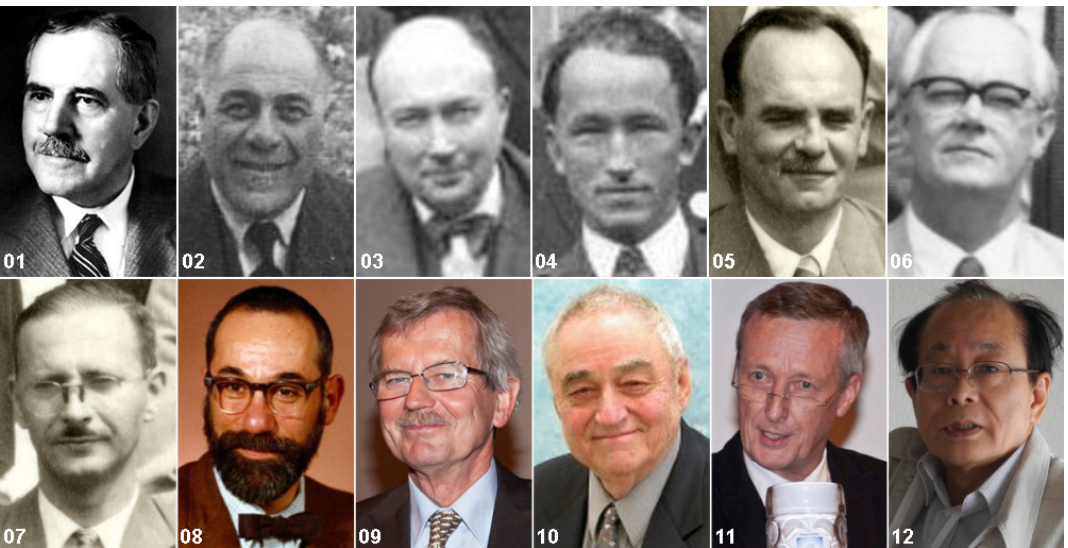
Figure 4. Collection of portraits of the 12 IAMAS secretaries-general serving from 1919 to 2019: (01) Charles Marvin, (02) Filippo Eredia, (03) Philippe Wehrlé, (04) Jacob Bjerknes, (05) Jacques van Mieghem, (06) Reginald Sutcliffe, (07) Warren Godson, (08) Stanley Ruttenberg, (09) Michael Kuhn, (10) Roland List, (11) Hans Volkert and (12) Teruyuki Nakajima. See Table 3 for detailed information. Photo credits: 03 and 04 , cuttings from group photograph of 1936 (Bojkov, 2012; Fig. 4; © Oxford University); 05–07 cuttings from group photograph of 1959 (© B. J. Harris; Ohring et al., 2009); 09 and 11 in October 2011 (© Markus Weber); 12 in June 2015 (© Hans Volkert); and other portraits from web